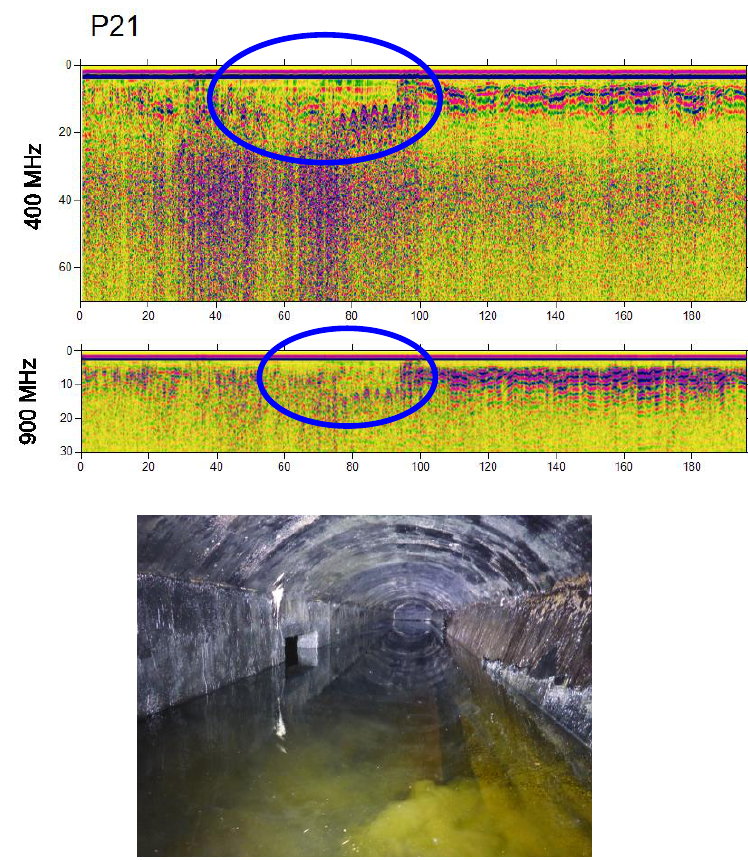
Figure 23. Hradčany Square. GPR anomalies above the underground reservoir. Figure 23. Hradˇcany Square. GPR anomalies above the underground